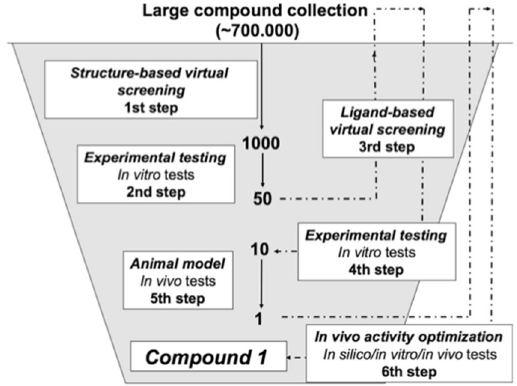
Figure 1. Flowchart of the screening protocol used in the study. 1st step . A collection of 700,000 drug-like commercially available compounds was screened in silico . Molecular docking was performed using Surflex- dock version 2.5. After visual inspection, a 1000 compound hit list was selected for experimental testing. 2 nd step : The inhibitory activity of the compounds composing the hit list was evaluated in vitro on human TNF α induced apoptosis on the L929 cell line. Top hit compounds displayed an IC 50 between 1 and 100 µ M. 3 rd step : 2D/3D similarity search methods were used to identify analogues of the top hits identified after step 2. Up to 100 analogues were found per top hit with a Tanimoto similarity score > 0.6. 4 th step : As in step 2,